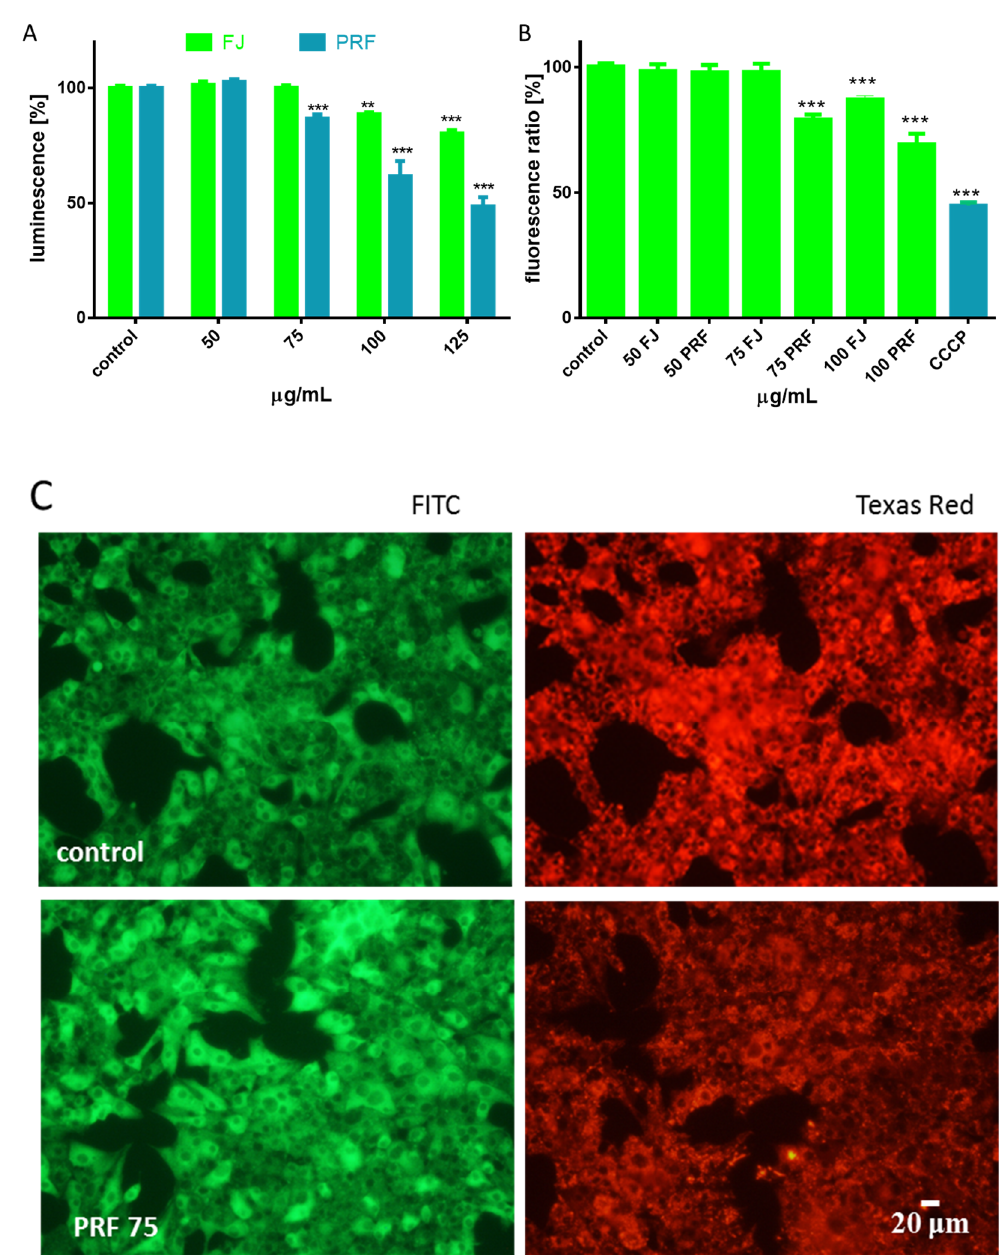
Figure 3. The influence of V. opulus extracts on the MIN6 cell ATP level determined by ATP luminescent assay after 24 h exposure of FJ and PRF ( A ); mitochondrial membrane potential was determined with JC-1 probe ( B ), where a positive depolarization control carbonyl cyanide m-chlorophenyl hydrazine (CCCP) was used (50 µ M); control cells were not exposed to any compound but the vehicle; values are means ± standard deviations from at least three independent experiments, n ≥ 9; statistical significance was calculated versus control cells (untreated), ** p ≤ 0.01, *** p ≤ 0.001; fluorescent images of MIN6 cells stained with JC-1, where randomly chosen fields were photographed at × 200 magnification with FITC and Texas Red filters ( C ).